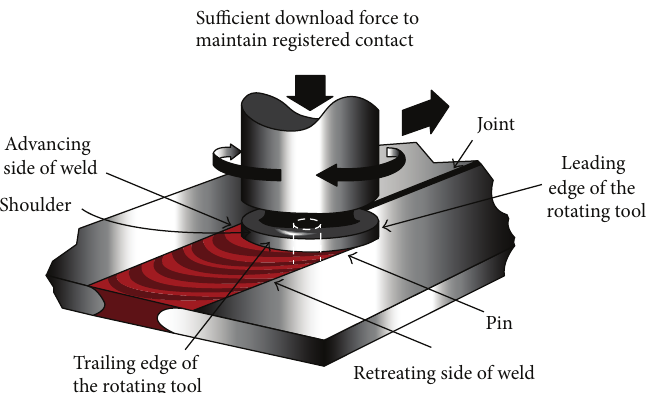
Figure 1: The schematic representation of FSW process.